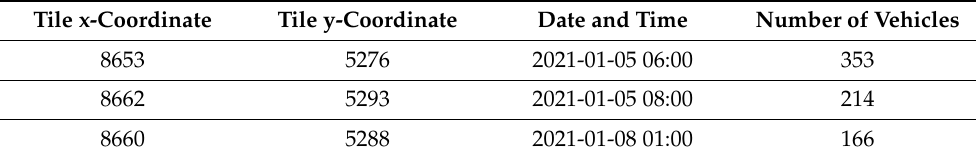
Table 1. Sample of data obtained from